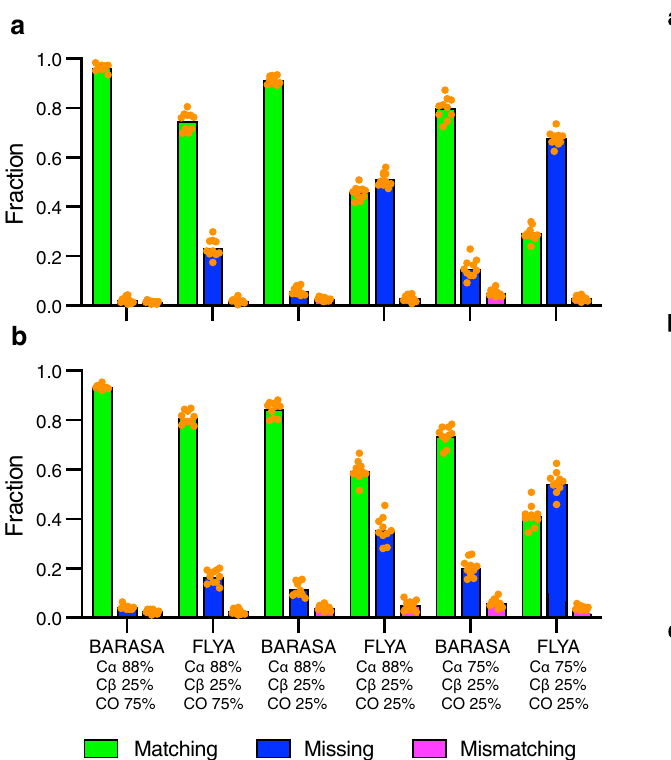
Fig. 6 | Performance of BARASA and FLYA with depleted crosspeak lists. The effects of random crosspeak depletion on the analysis of MBP ( a ) and ecTS ( b ) comprehensive triple resonance data sets with partial retention of the indicated crosspeak types (see text and Fig. 4). Shown are the fractions of residues that are accurately matched (green), mismatched (magenta) or missing (i.e., unassigned) (blue) to the reference assignments. Ten independent data sets ( n =10) were ran- domly generated for each depletion condition. The results of analysis by BARASA for each data set are shown as solid orange circles and the bar heights correspond to the mean. Source data are provided as a Source Data fi le. Fig. 7 | Sensitivity of automated resonance assignment of Cy1 to breadth of